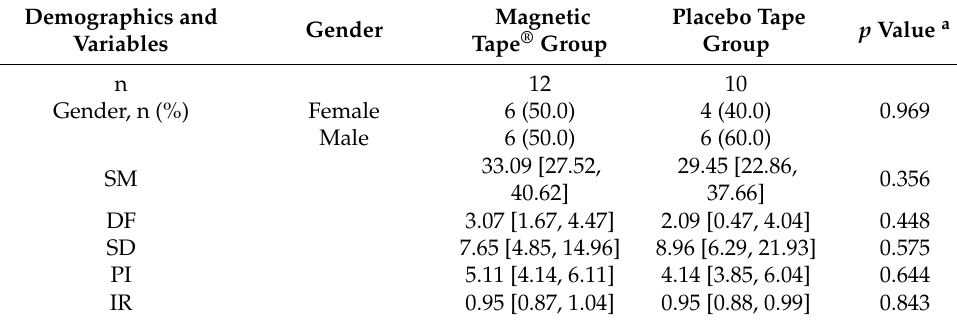
Table 1. Participant baseline demographic and clinical characteristics. Demographics and